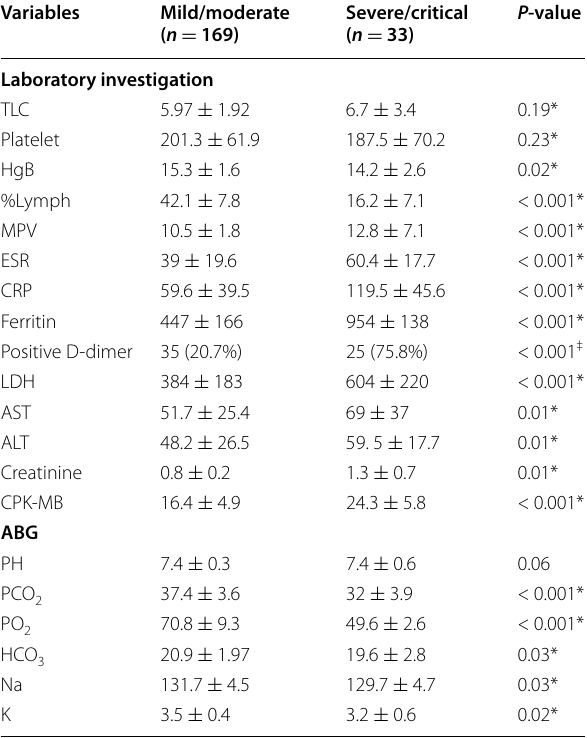
Table 4 Laboratory assessment of the studied COVID-19 patients on admission